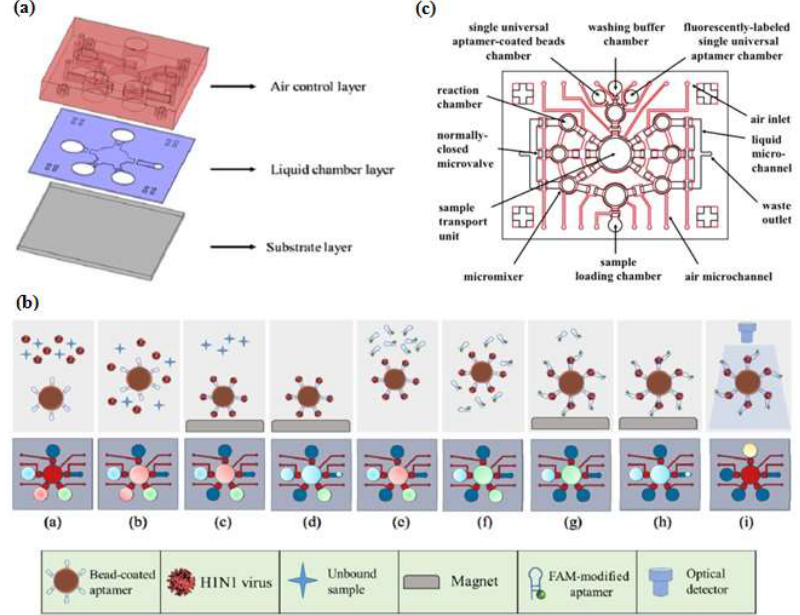
Figure 5. Integrated microfluidic chip system using a sandwich aptamer. ( a ) The device was composed